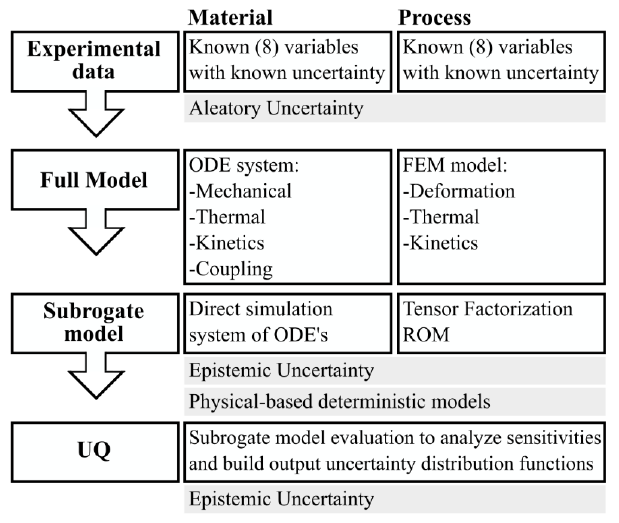
Figure 1. Summary of the uncertainty management methodology with application to material transformation processes.